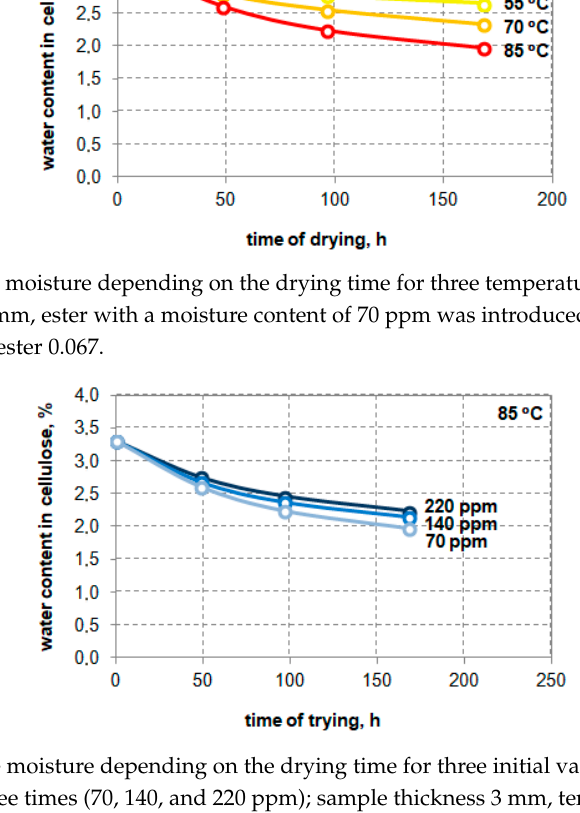
ratio of cellulose to ester 0.067.